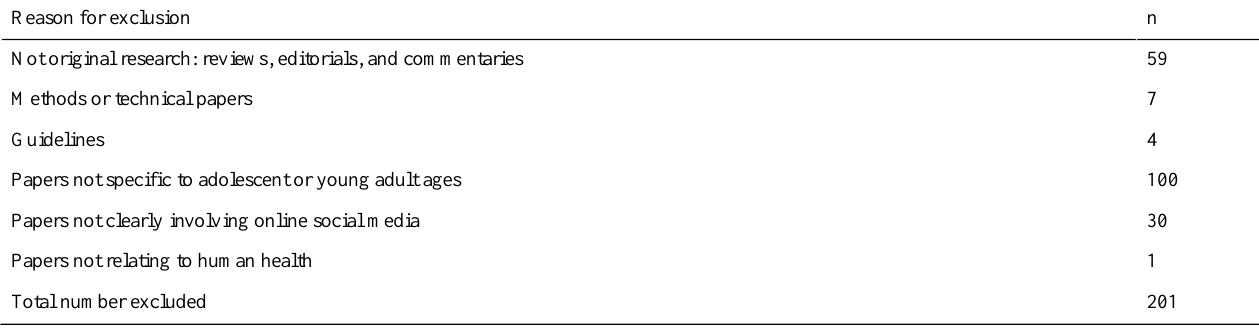
Table 3. Summary of reasons for exclusion from systematic review